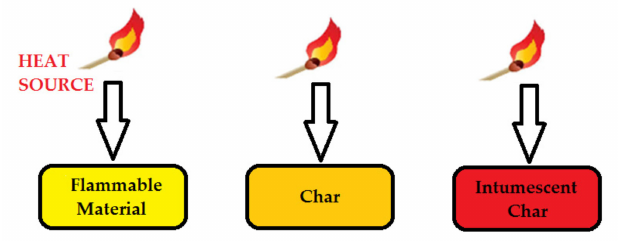
Figure 5. Char and intumescence